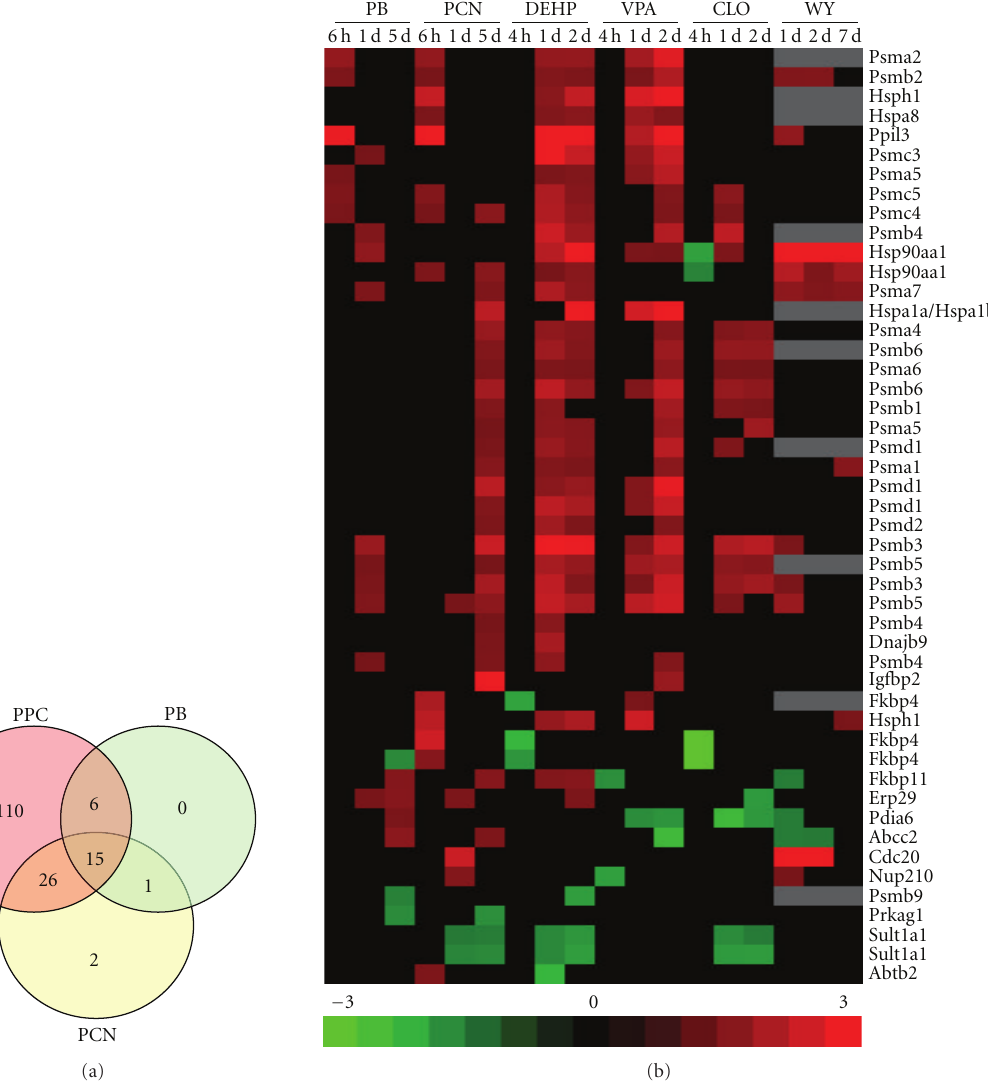
Figure 6: Comparison of the expression of the PM genes after exposure to PPAR α , CAR and PXR activators. Lists of di ff erentially regulated genes were generated after exposure to phenobarbital (PB), pregnenolone-16alpha-carbonitrile (PCN) or the PPC. The expression of the PM genes (probe sets) were compared between the treatments. (a) Overlap in the PM gene probesets that were altered in one or more of the three time points after PB or PCN exposure or after 3 or 4 of the 4 PPC treatment groups are shown. (b) The 47 overlapping gene probe sets were clustered as described